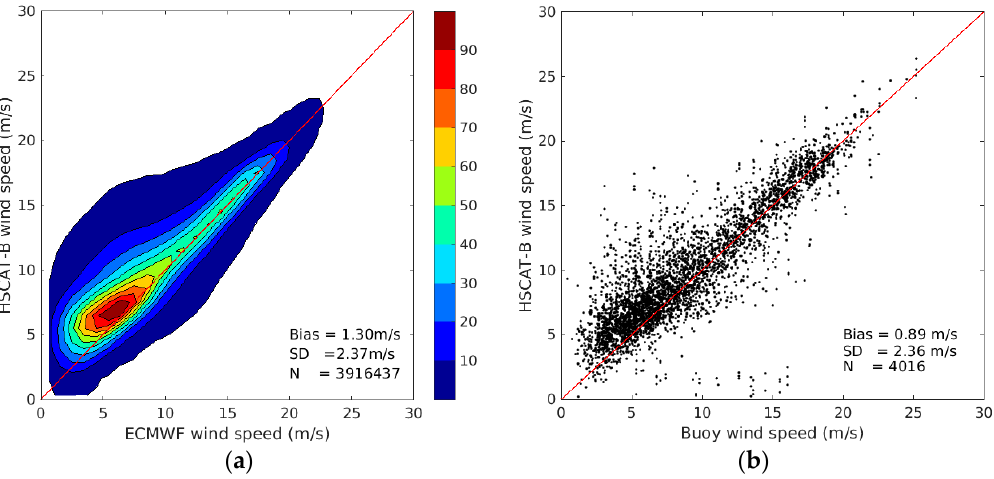
Figure 2. ( a ) Two-dimensional histogram of HSCAT-B QC-rejected data versus ECMWF winds (bins of 1 m/s), and ( b ) scatter plot of HSCAT-B QC-rejected data versus buoy wind speed. In ( a ), the color bar indicates the ratio (%) of data with respect to the maximum data bin, i.e., the lowest contour line level is 1%, and the following steps are 10%, 20%,..., and 90%.